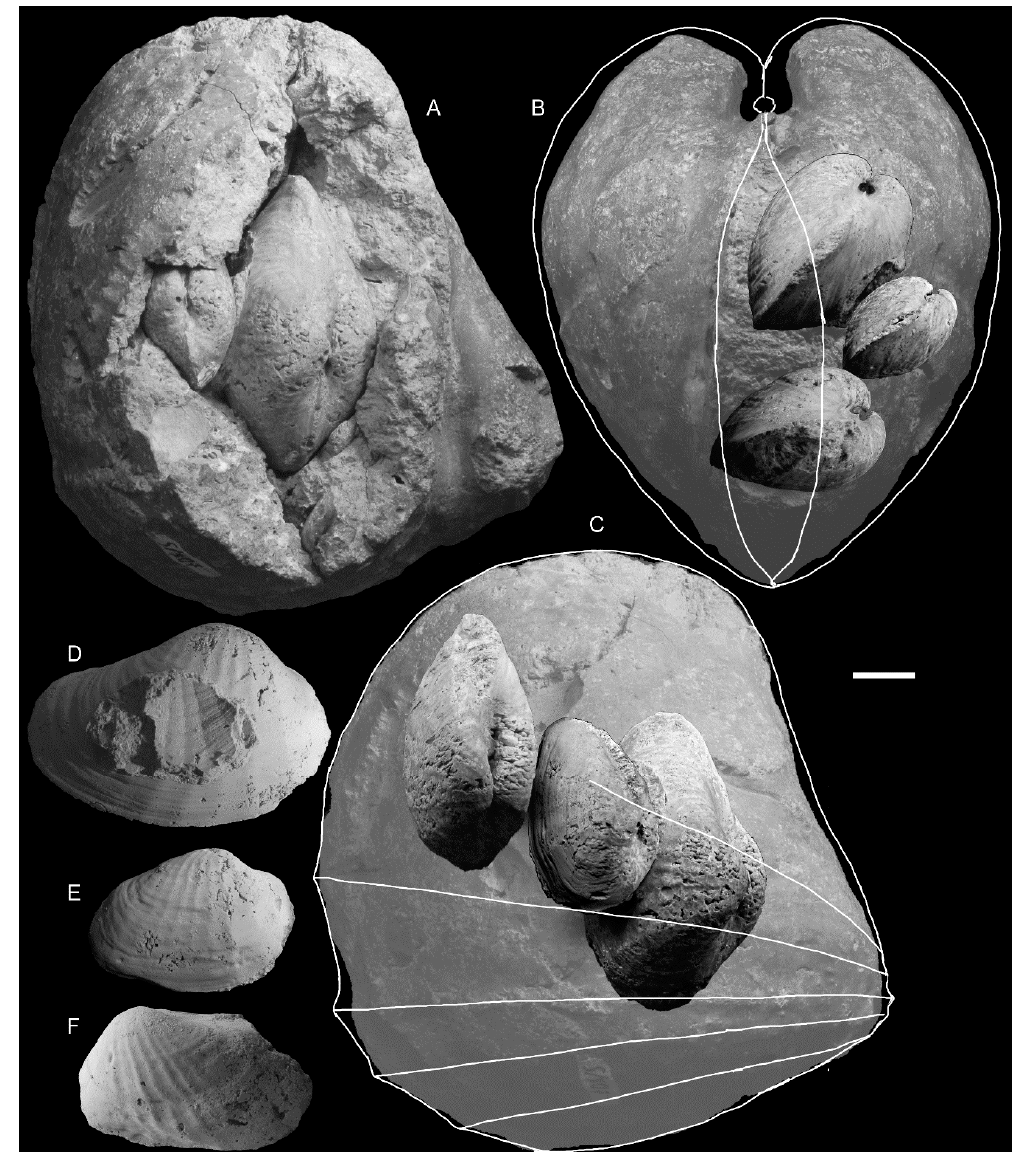
Figure 9. Pholadomya aequalis from the Lower Kimmeridgian in Western Pomerania (NW Poland): ( A – C ), distribution of three specimens of Ph. aequalis inside a specimen of Ph. protei (Dziwnówek or Czarnogłowy, specimens MGUS.S / 267 and 307) in dorsolateral ( A ), posterior ( B ) and lateral ( C ) view. ( D ), the largest specimen of Ph. aequalis with a hole eroded by the smallest specimen. ( E ), the smallest specimen of Ph. aequalis with a deformed postero-ventral edge. ( F ), another malformed specimen from Czarnog ł owy (MGUS.Sz.3460).